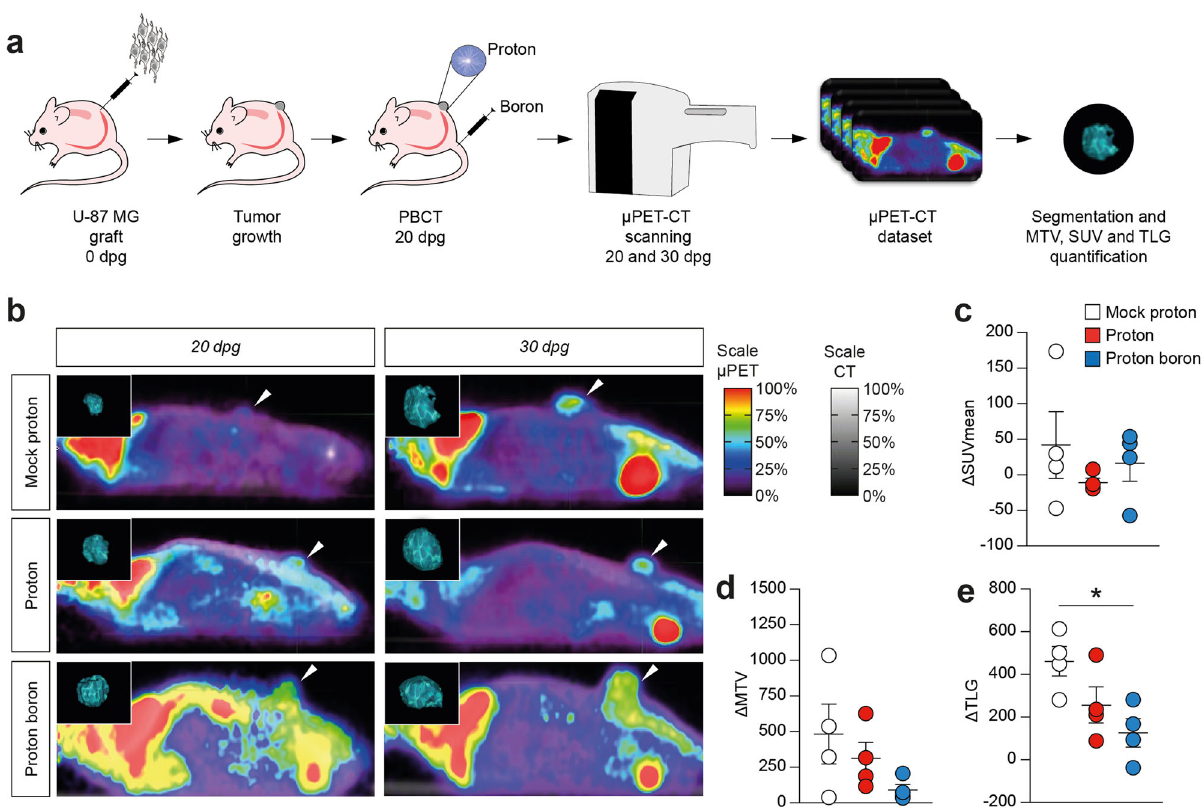
Fig. 2 Proton irradiation and proton boron capture therapy induce a reduction of SUV at 30dpg. a Experimental setting for GBM induction, proton irradiation and FDG PET scanning. b Representative FDG PET images of mock proton, proton-treated and proton boron-treated mice. c – e Quanti fi cation of Δ SUV, Δ MTV and Δ TLG between 20 and 30dpg in mock proton (white circles), proton-treated (red circles) and proton boron-treated (blue circles) mice. * p -value < 0.05. Dpg days post-graft, SUV standardized uptake value, MTV metabolic tumor volume, TLG total lesion